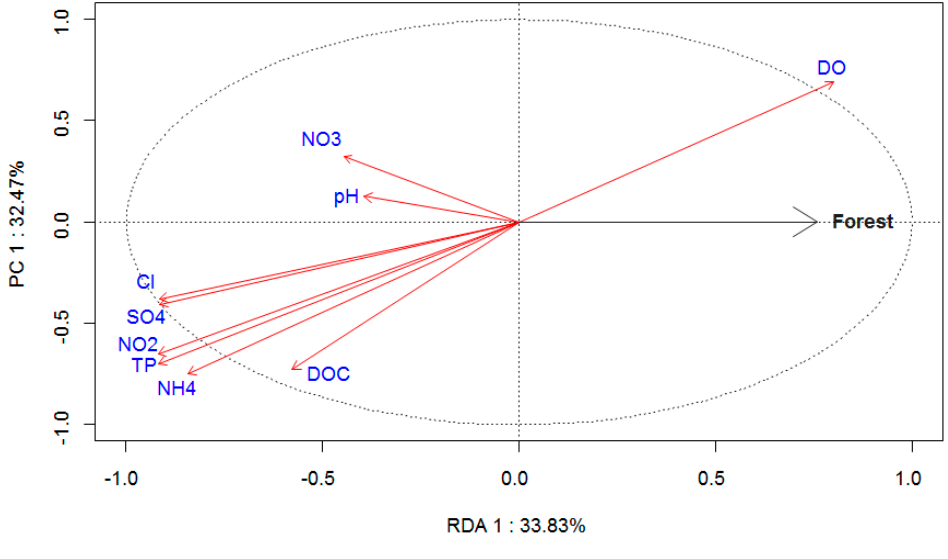
Table 2. Redundancy analysis results for seasonal dataset (October–March and April–September) and aggregated dataset (median value over the study period): variability (%) explained by forest cover, by covariates and shared